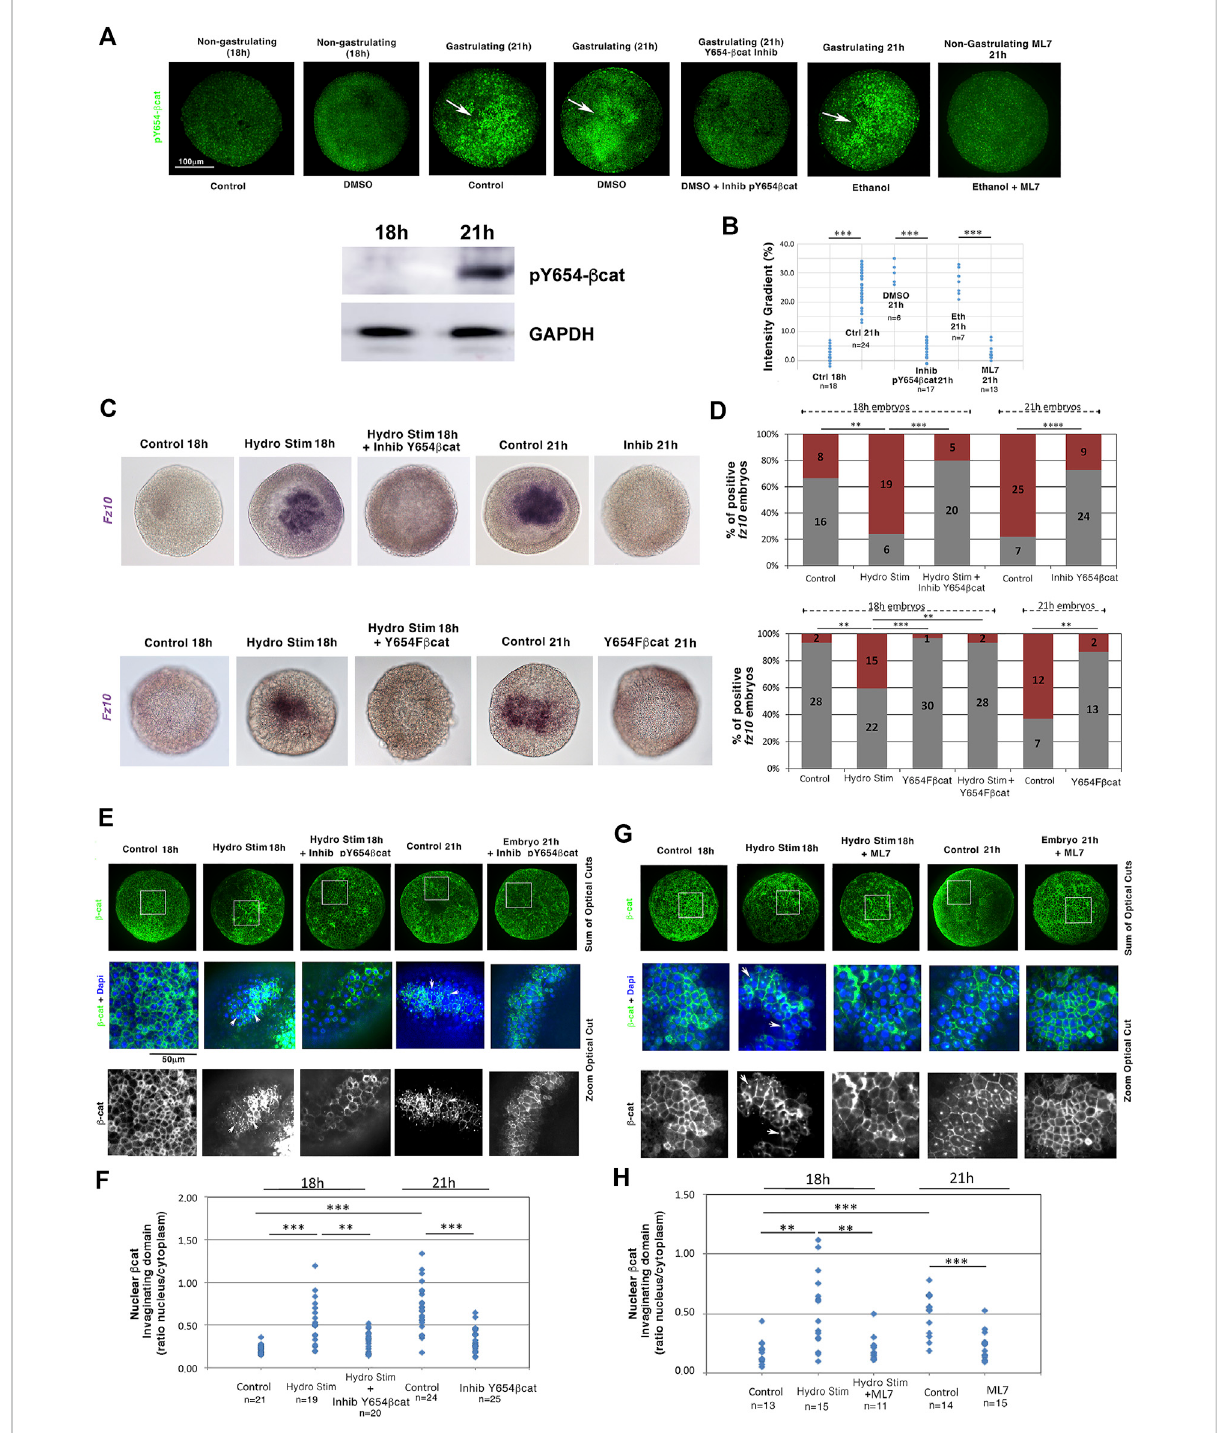
FIGURE 4 Mechanicalinductionoftheendomesodermal fz10 geneexpressionisinitiatedbythemechanicalactivationofY654- β -catphosphorylation. (A) Y654- β -cat phosphorylation in blastulae (18 h), gastrulae (21 h), and 21 h gastrulae embryos treated with either InhibY654- β cat, the inhibitor of Y654phosphorylation,orML7,theinhibitorofgastrulation.Westernblot:Anti-pY654 β -cateninproteindetectionbywesternblottingof N.vectensis embryos at 18 h and 21 h of development. GAPDH was used as the loading reference. (B) Quanti fi cation of the gradient ratio (in percentage) of Y654- β -cat phosphorylation in invaginating compared to non-invaginating domains and from domains of maximal intensity compared to the other domains in non-gastrulating embryos of (A) . n DMS021h = 6 and n InhibY654bcat21h = 17, p = 2.3.10 – 4 , n Eth21h = 7 and n ML721h = 13, p = 2.10 – 4 .